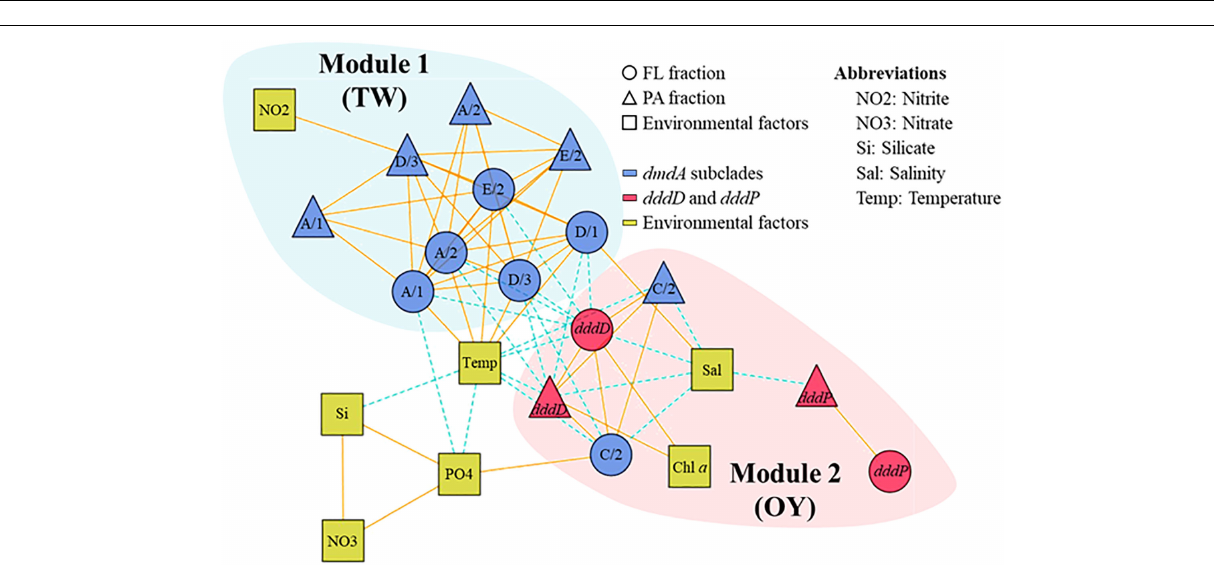
FIGURE 8 | Association network of dimethylsulfoniopropionate (DMSP) degradation gene abundances in relation to environmental factors in the field study. The different modules are shaded with different colors. Most of the dmdA subclades were clustered in one module, while dddD , dddP, and dmdA subclade C/2 to a different module. Solid lines indicate positive correlations, while dashed lines indicate negative